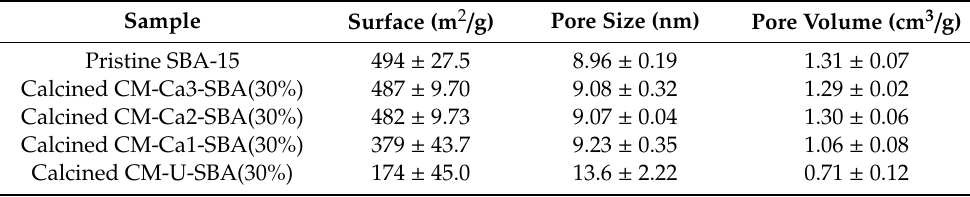
Table 1. The specific surface area, pore diameter and pore volume analysis of particles.